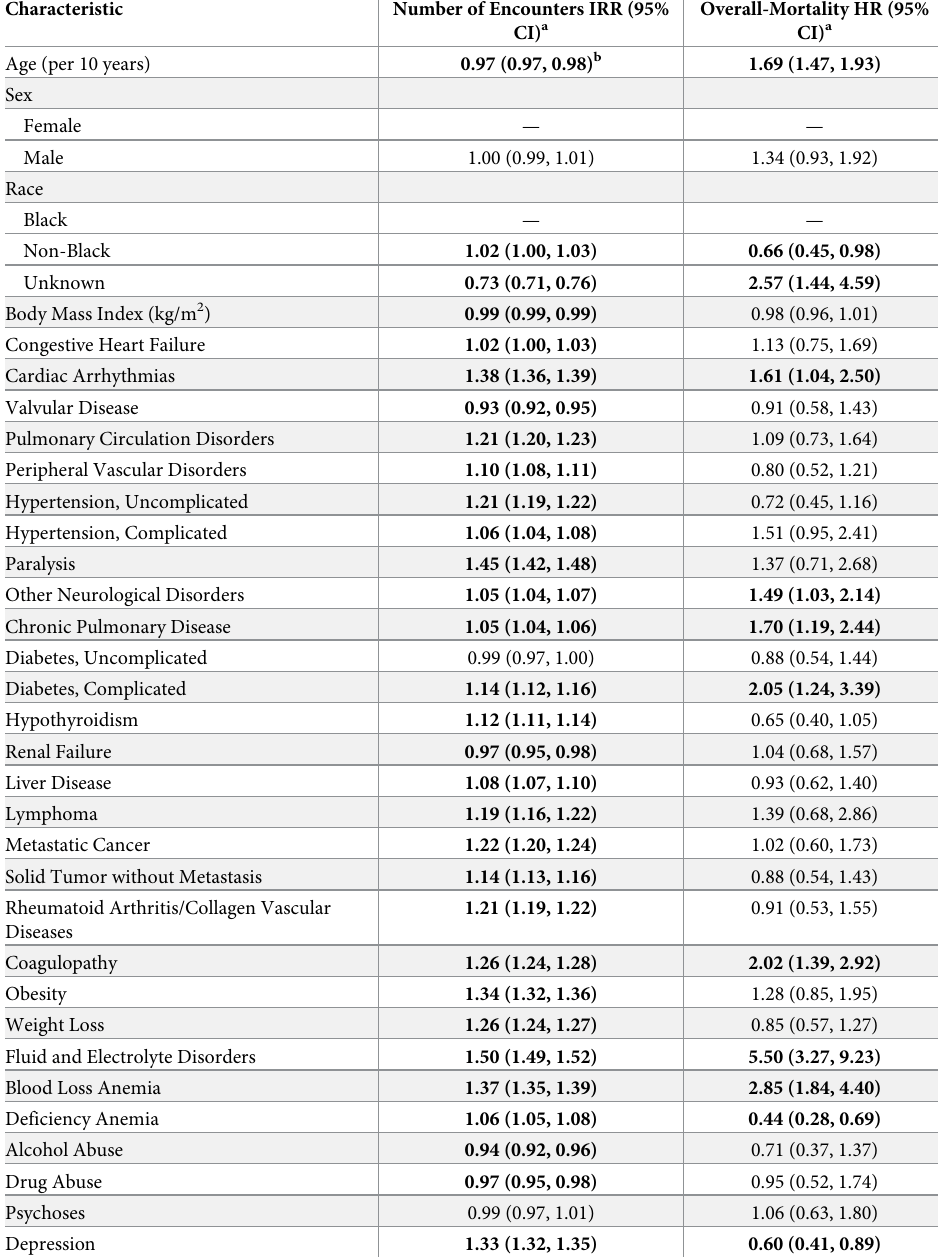
a IRR = Incidence Rate Ratio, CI = Confidence Interval, HR = Hazard Ratio b Bold values indicate statistical